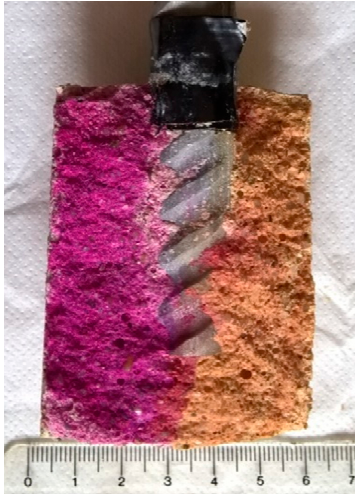
Figure 2. Image of a broken reinforced sample previously exposed to CO 2 , after the use of phenolphthalein (left) and yellow alizarin (right) indicators to check pH.